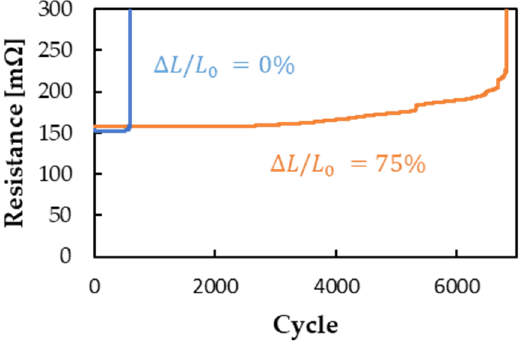
Figure 9. The result of the cycle test with strain up to 30% for samples prepared using gears with module 0.15 and a pre-stretch ratio of 0% or 75%.